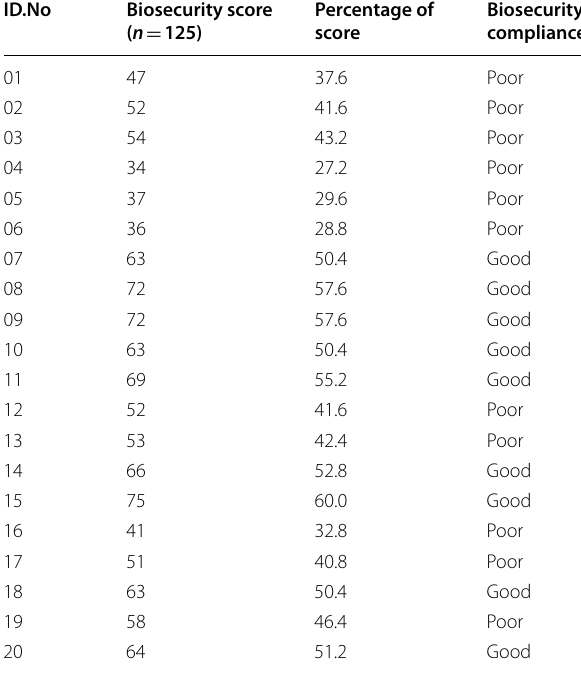
Table 9 Summary of general biosecurity score, percentage and Implementation status of dairy herd owners in and around Harar and Dire Dawa